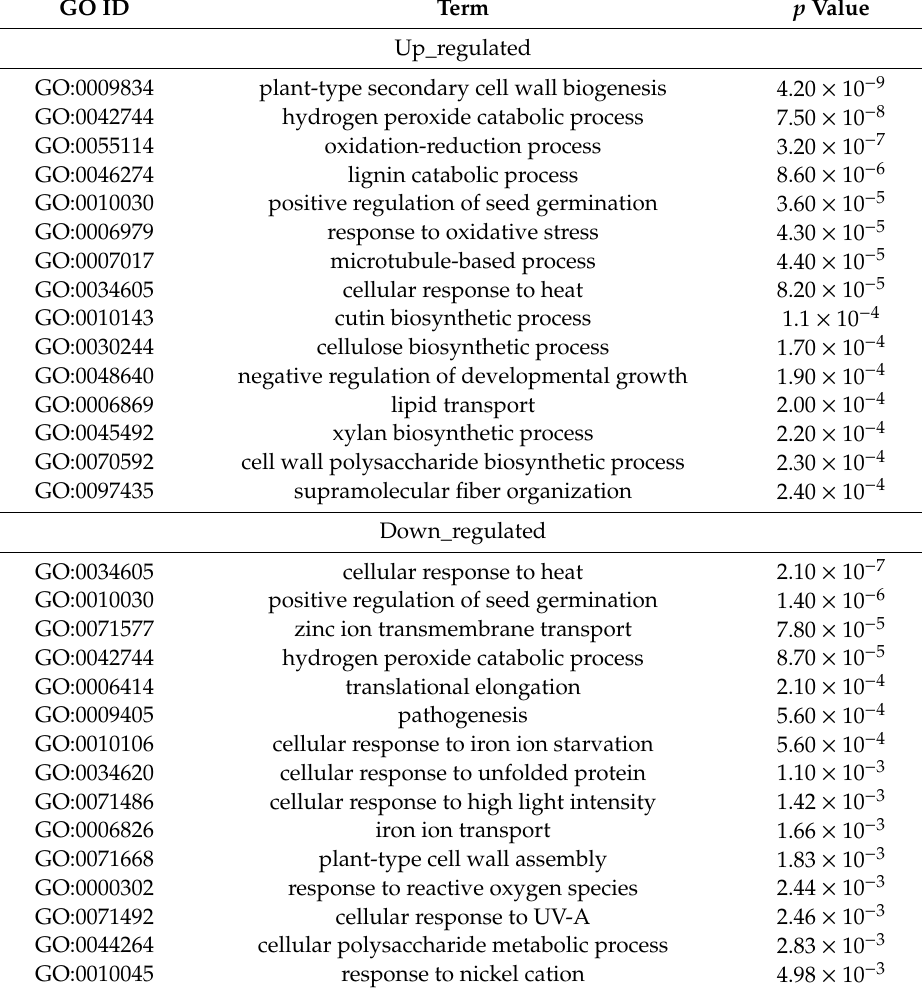
Table 3. Top30 biological processes enriched by the upregulated and downregulated genes. GO